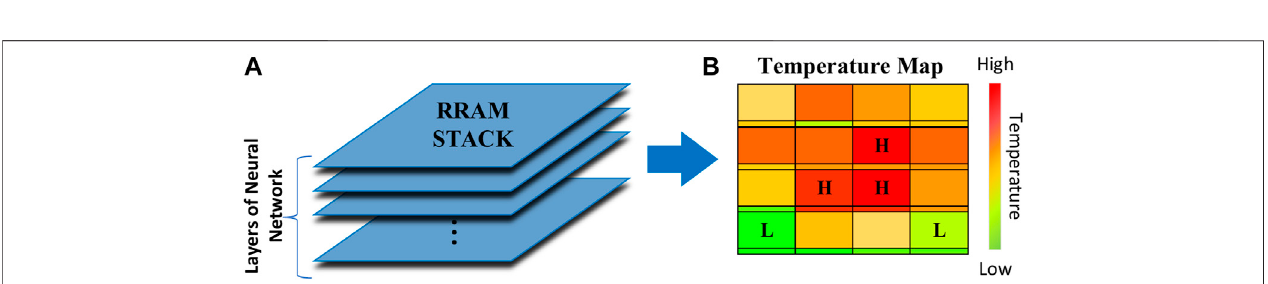
FIGURE 3 | (A) 3-dimensional RRAM crossbar array stack for higher area ef fi ciency, (B) temperature map in RRAM stack.